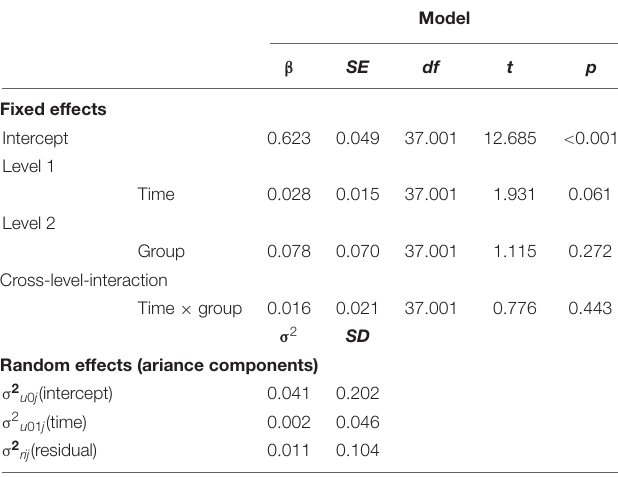
TABLE 2 | Model 1: Random intercept and slope model for cardiac interoceptive accuracy with the predictors time, group, and the interaction of time and group.